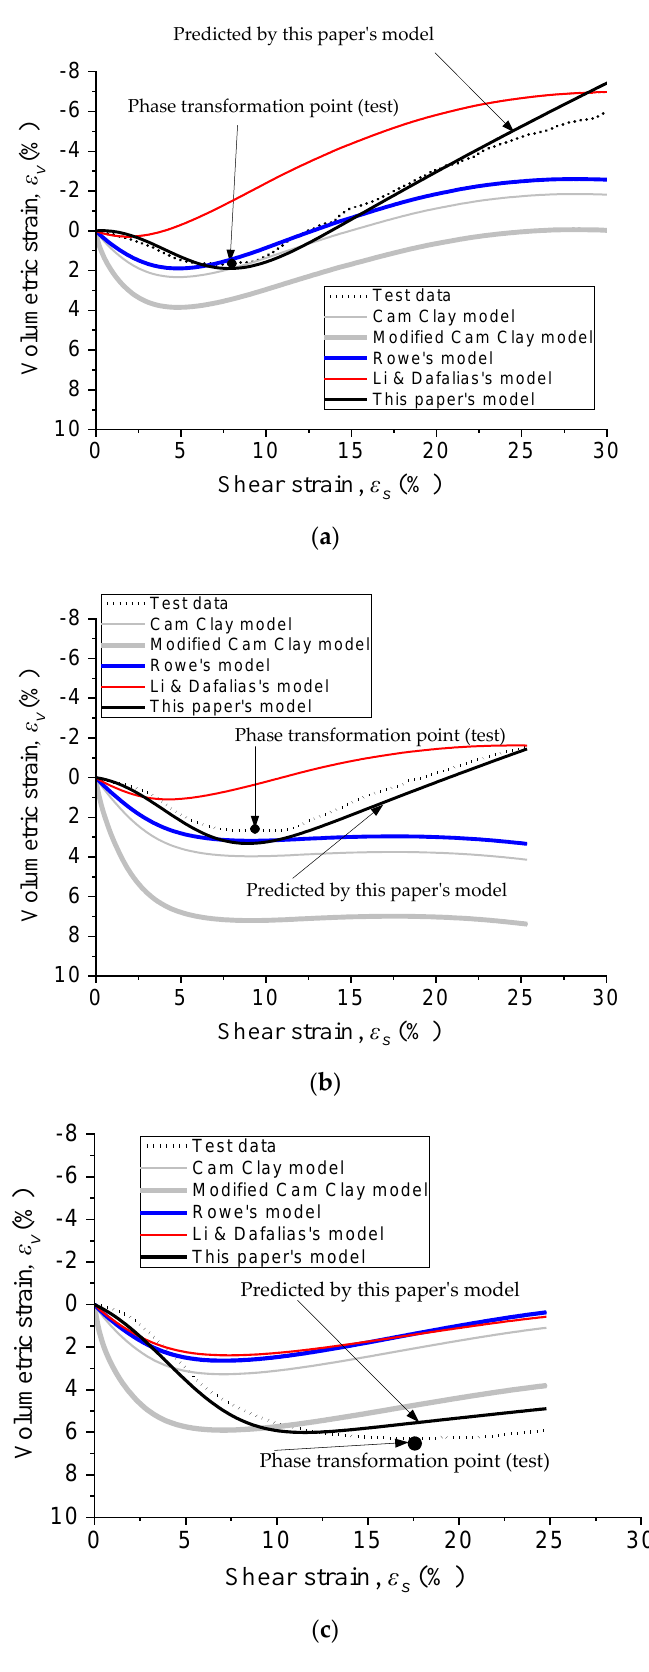
Figure 15. Comparison of predictions of volumetric strain: ( a ) p (cid:48) ( c ) p (cid:48) = 600 0